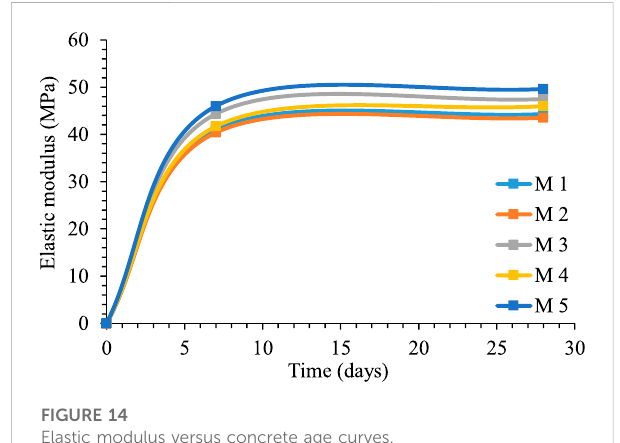
Elastic modulus versus concrete age curves. FIGURE 15